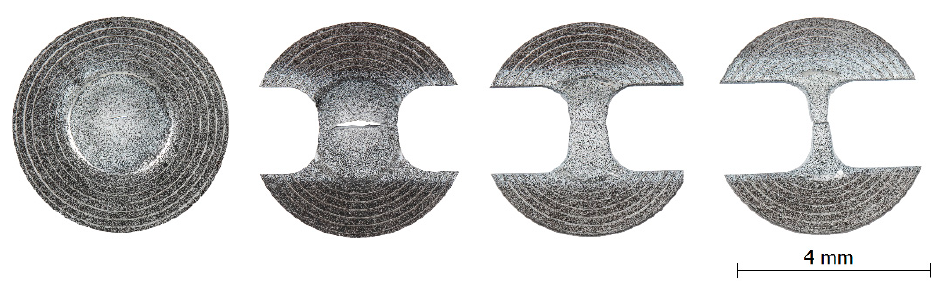
Figure 6. The miniaturized specimen geometries for FLD evaluation which correspond to the Nakajima original theory (specimen widths from the left: 4, 8, 16 and 40 mm) after testing.